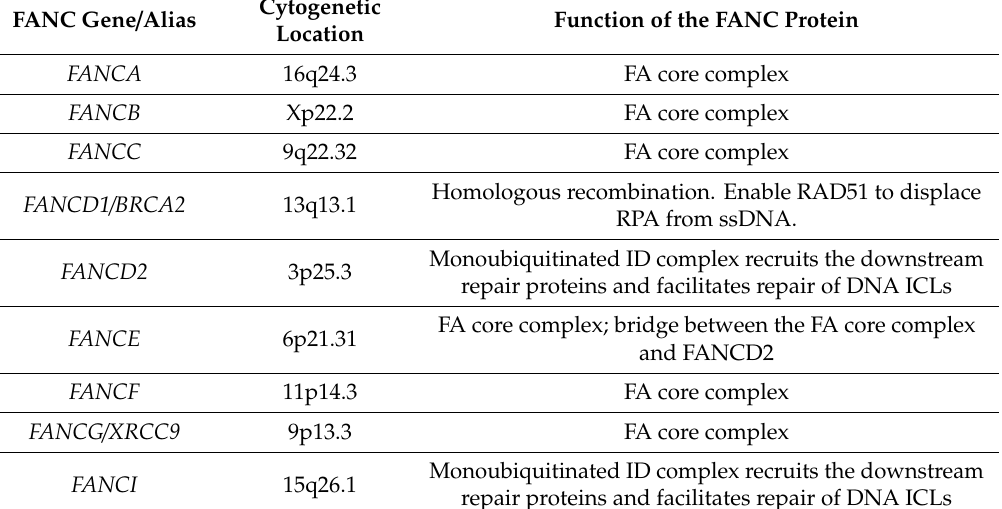
Table 1. Fanconi anemia genes involved in FA / BRCA pathway 1